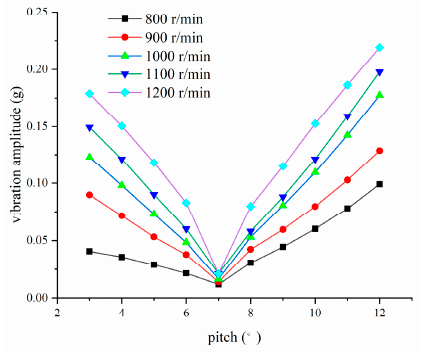
Figure 21. Vertical amplitude diagram of pitch.